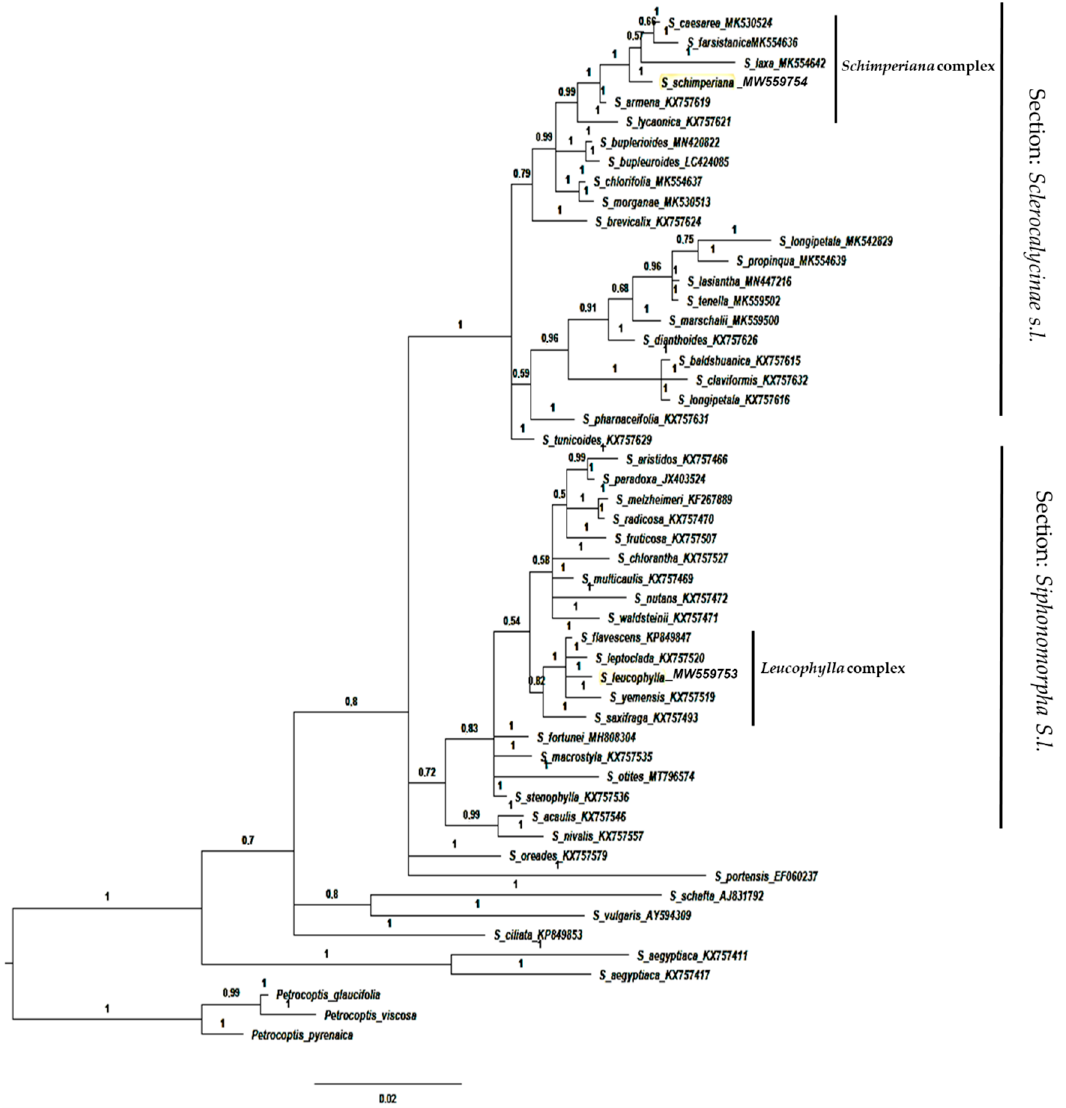
Figure 8. Bayesian phylogenetic tree of Silene species based on nrDNA sequences of the ITS marker. Numbers above branches represented (PP).